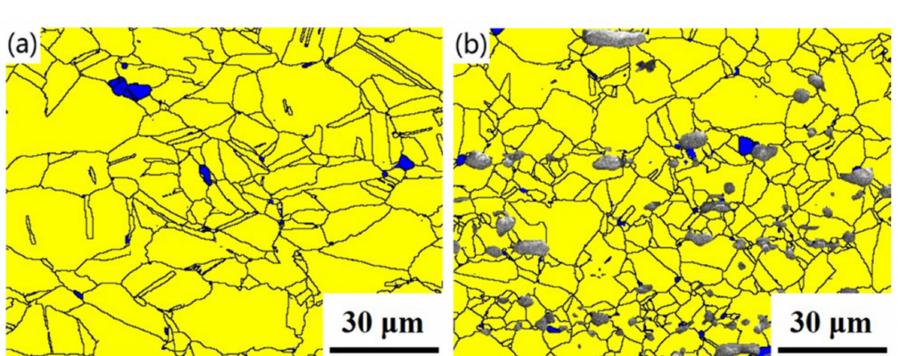
Figure 5. γ grains segmented into recrystallized (in blue) and non-recrystallized (in yellow) fractions after annealing at 700 ◦ C. ( a ) 0B-700; ( b ) 30B-700. Grain boundaries are shown in black. Areas of M 2 B in ( b ) are shown by band contrast. Rolling direction = horizontal, thickness direction =